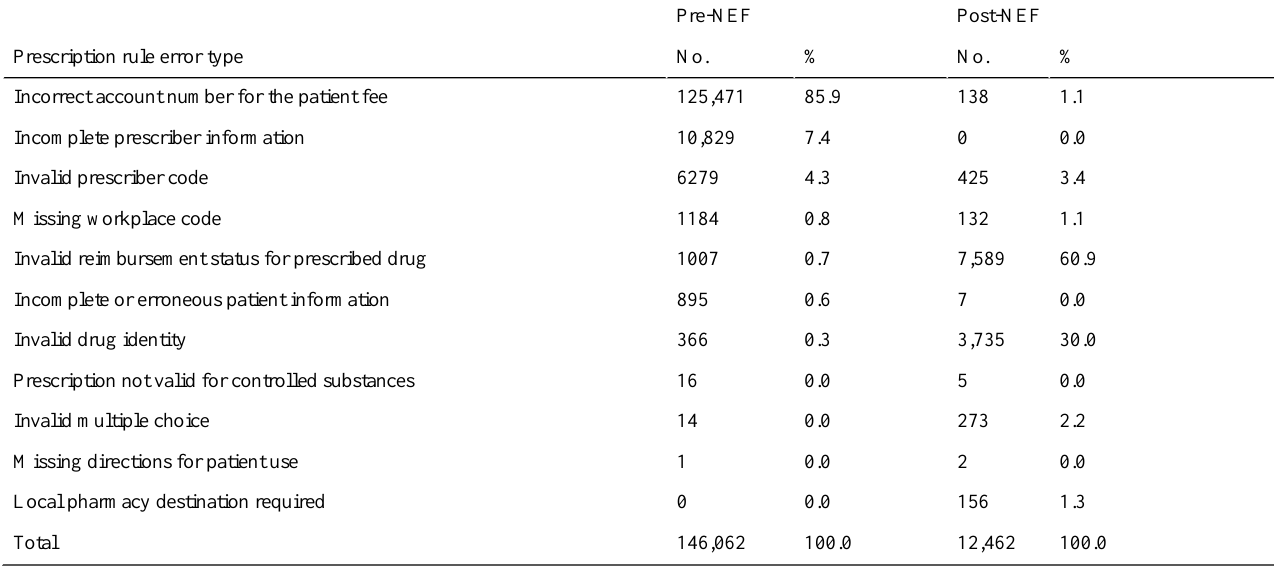
Table 12. Number of prescription rule errors grouped by type and the pre-NEF and the post-NEF sample.